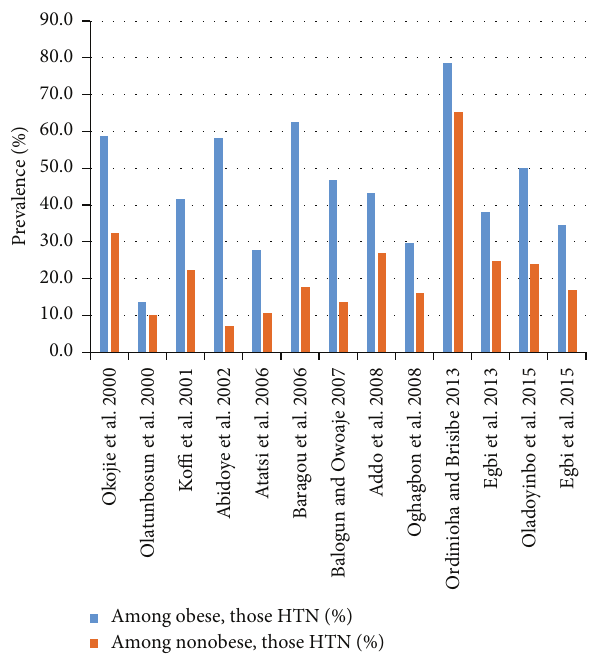
Figure 2: Prevalence of hypertension (HTN) in obese and nonobese